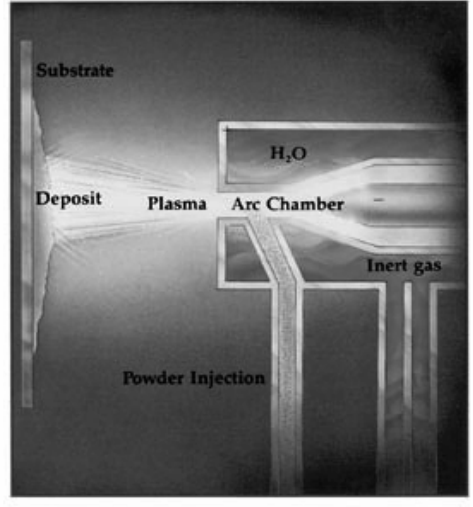
Fig. 1. Schematic of Are plasma spray process (APS Materials,